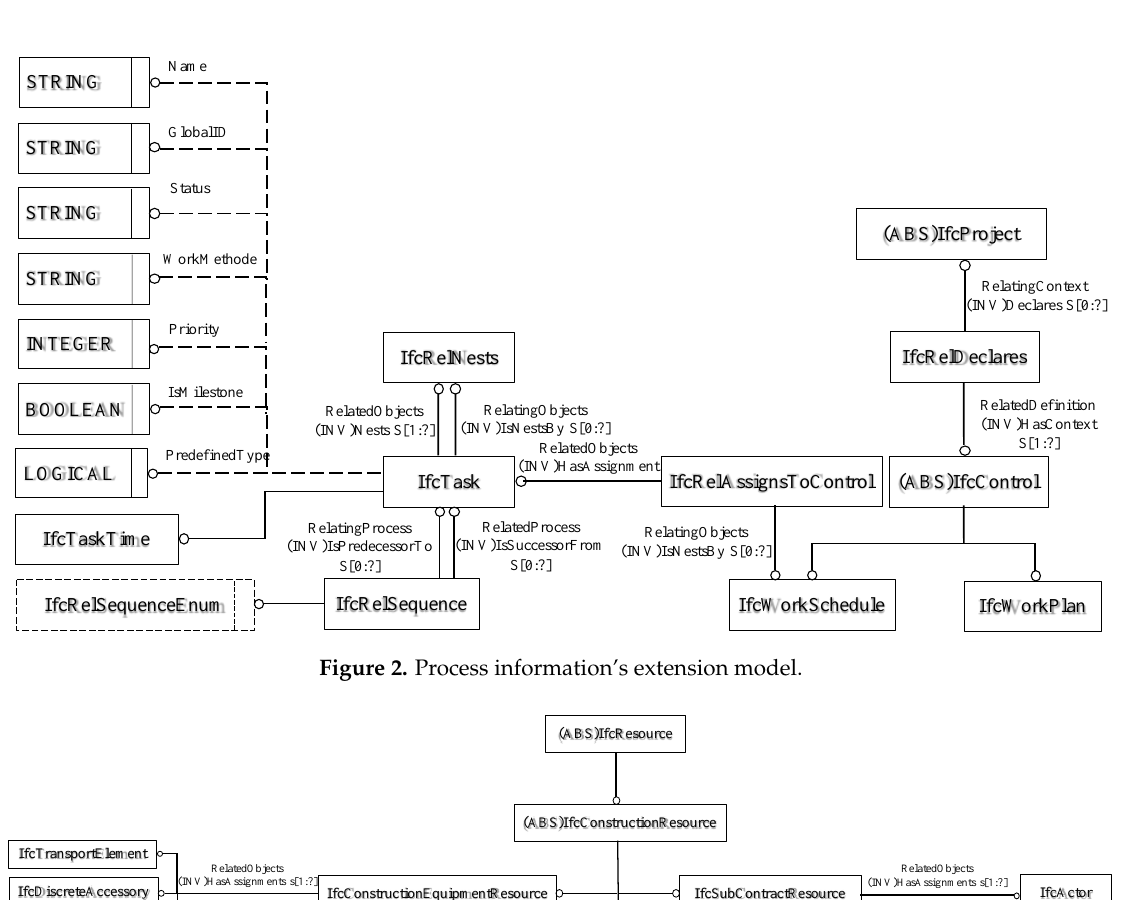
Figure 3. Resource information’s extension model.